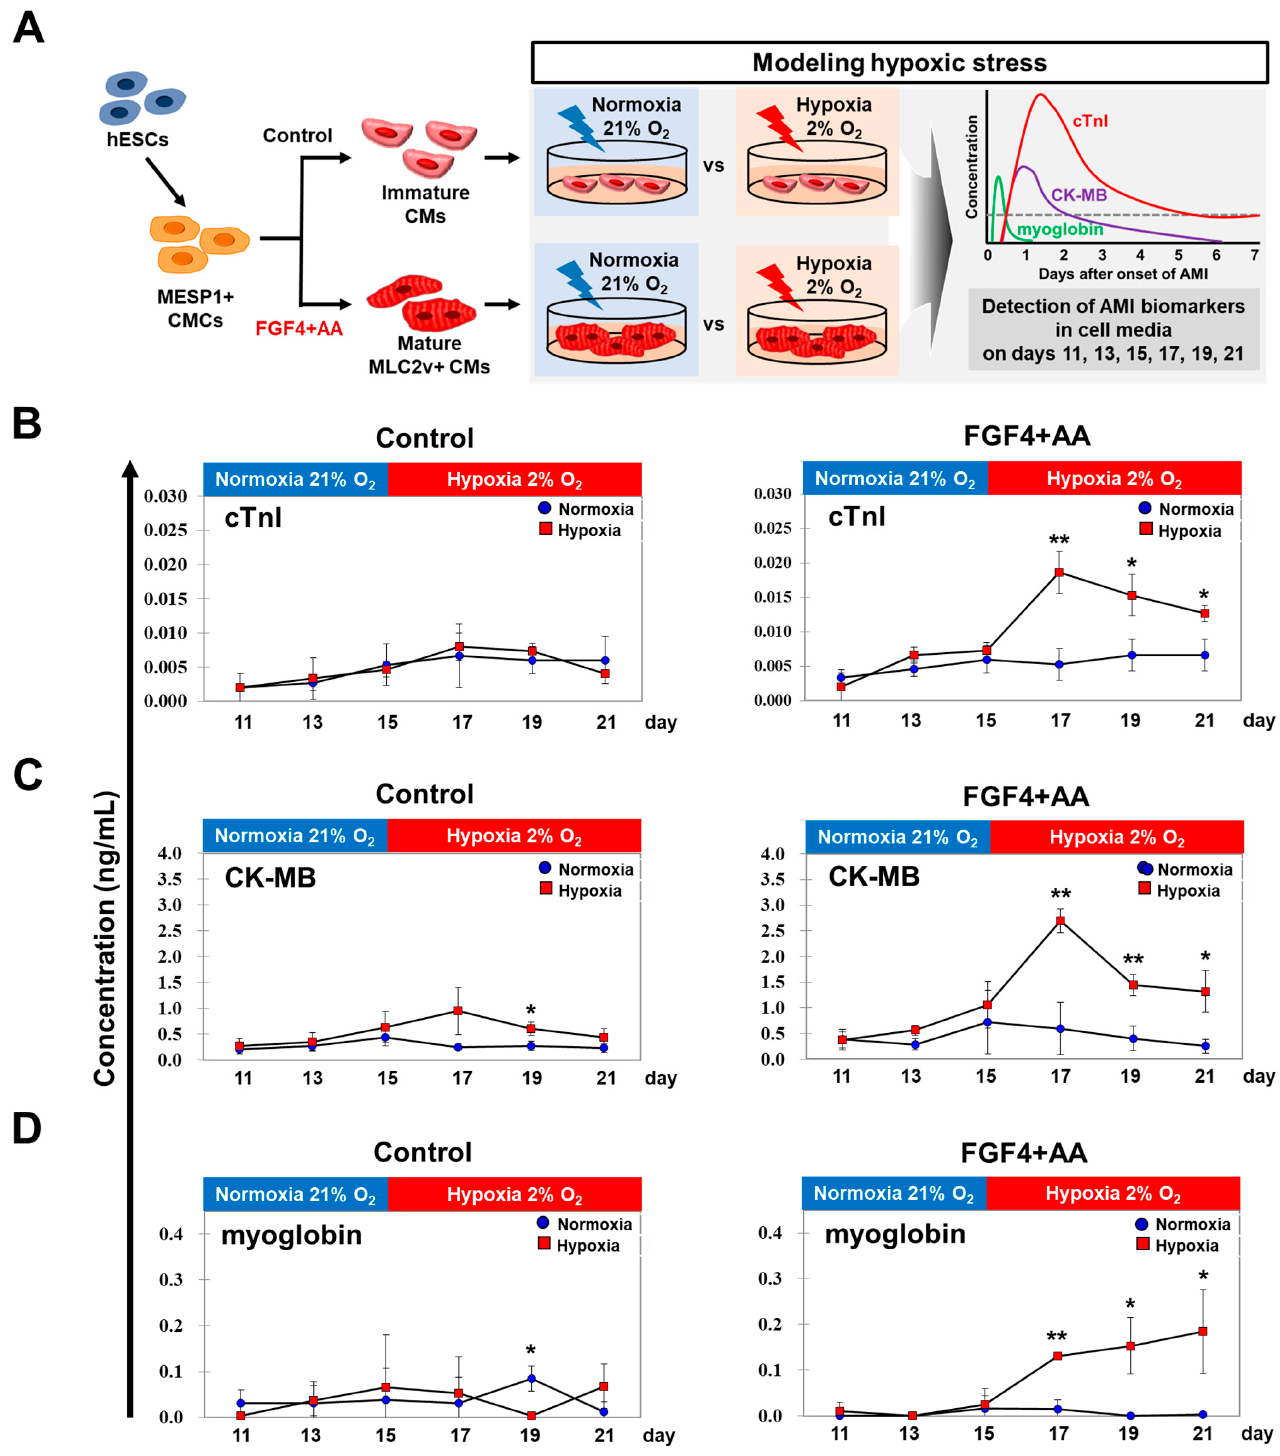
Figure 3. Non-invasive and continuous detection of AMI biomarkers from the culture medium of BG01 hESC-CMs. ( A ) Schematic diagram of detection of hypoxia-induced AMI biomarkers using hESCs cultured without or with 10 ng/mL FGF4 + 200 μ g/mL AA between days 5 and 15 of differentiation. Culture media from hESC-CMs grown under normoxic or hypoxic conditions for 24 h without 10 ng/mL FGF4 + 200 μ g/mL AA were collected every 2 days between days 11 and 21 of differentiation. CM: cardiomyocyte; CMC: cardiogenic mesoderm cell. AMI specific biomarkers, cTnI ( B ), CK-MB ( C ), and myoglobin ( D ) were evaluated using PATHFAST. Values represent means ± SDs. * p < 0.05 and ** p < 0.01 versus normoxia. Two-tailed unpaired Student’s t -test.